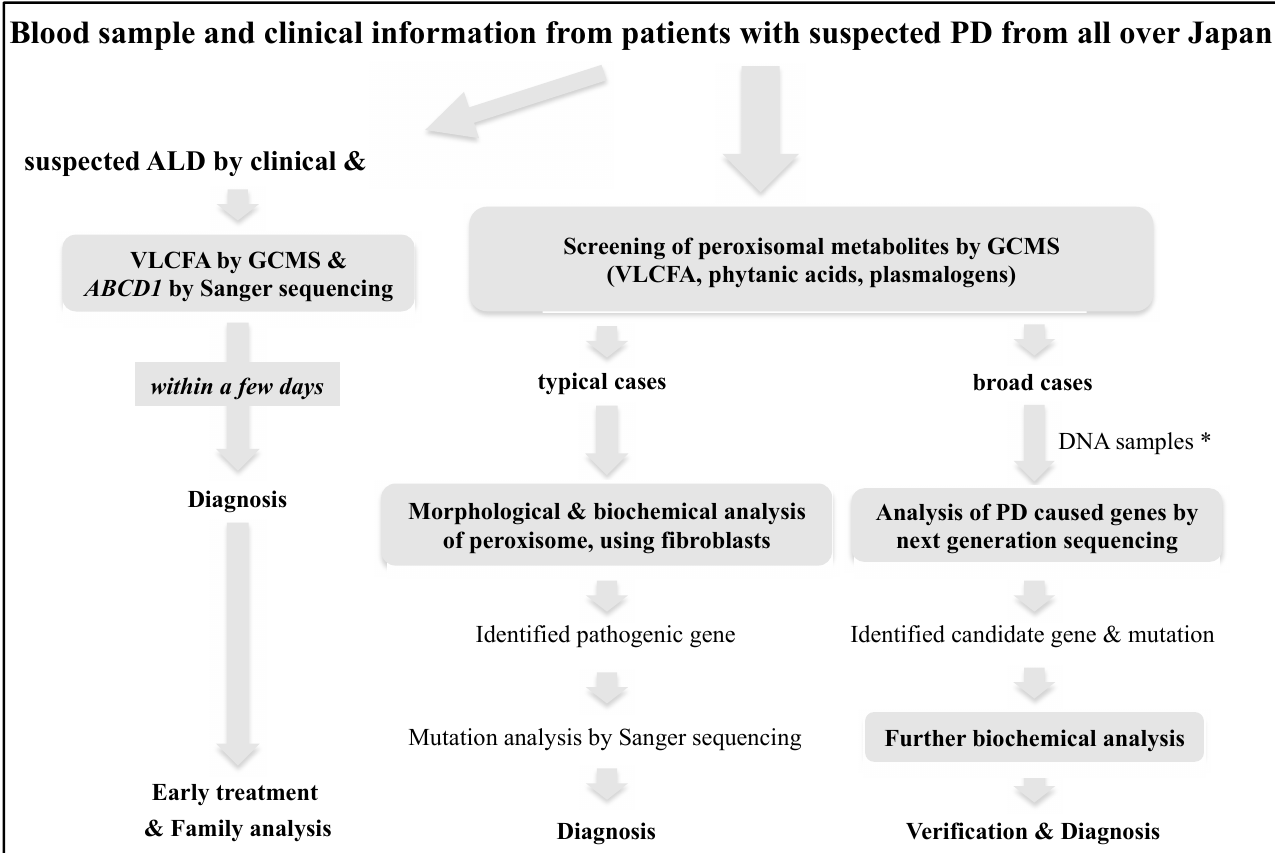
Figure 1. Diagnostic flowchart for adrenoleukodystrophy and peroxisomal disorders at Gifu University [8]. * collaborated with Hamamatsu University School of Medicine